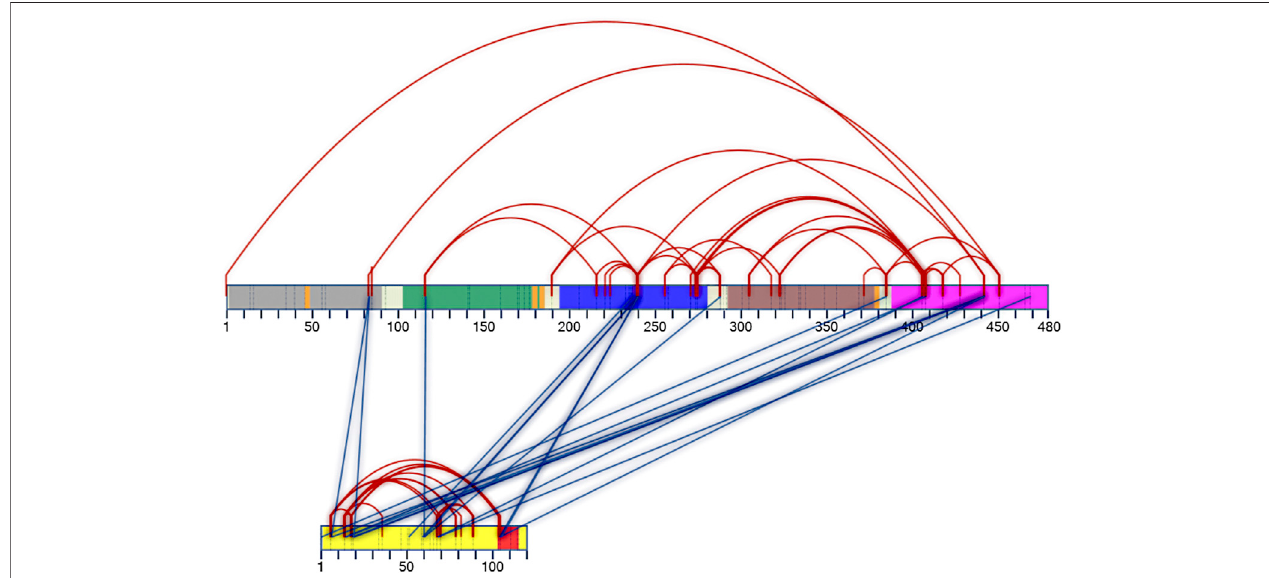
FIGURE 5 | Two-dimensional interaction map of DM64 in complex with myotoxin II. Protein sequences are represented by numbered rectangles in which vertical dashed lines indicate all potential target residues for cross-linking reaction. DM64 protein is colored according to Ig-like domains: D1: gray; D2: green; D3: blue; D4: brown; D5: pink. The four consensus sequences for N-glycosylation are shown in orange, and inter-domain linker regions are shown in white. The protein sequence of myotoxin IIis represented by ayellow rectangle, withthe C-terminalcationic/hydrophobic myotoxic site coloredin red. Intra-proteincross-links arerepresented by red lines, whereas inter-protein cross-links are shown in blue. Following identi fi cation by the SIM-XL software and manual veri fi cation, only good-quality spectra were used to build the 2D map.